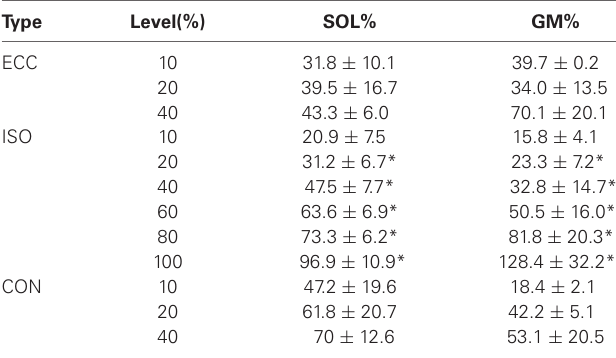
Table 1 | Relative surface EMG levels of soleus (SOL) and gastrocnemius medialis (GM) in different levels and contraction types, calculated relative to isometric MVC